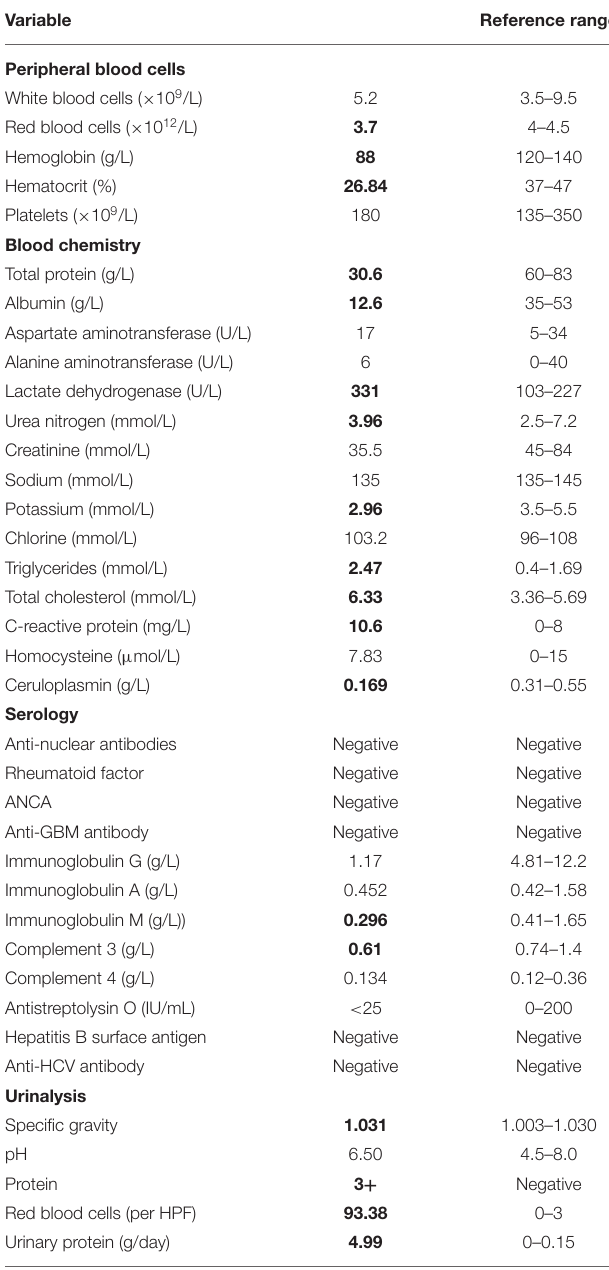
TABLE 1 | Baseline laboratory characteristics of the patient. Variable Reference